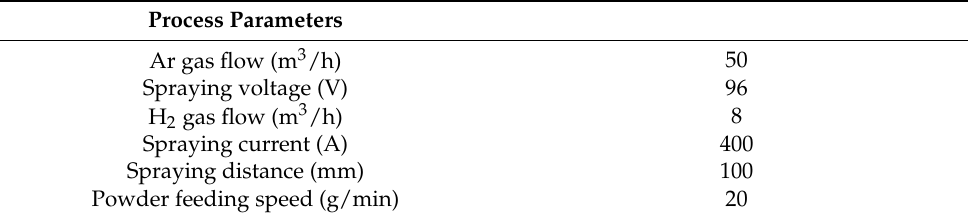
Table 1. Spraying process